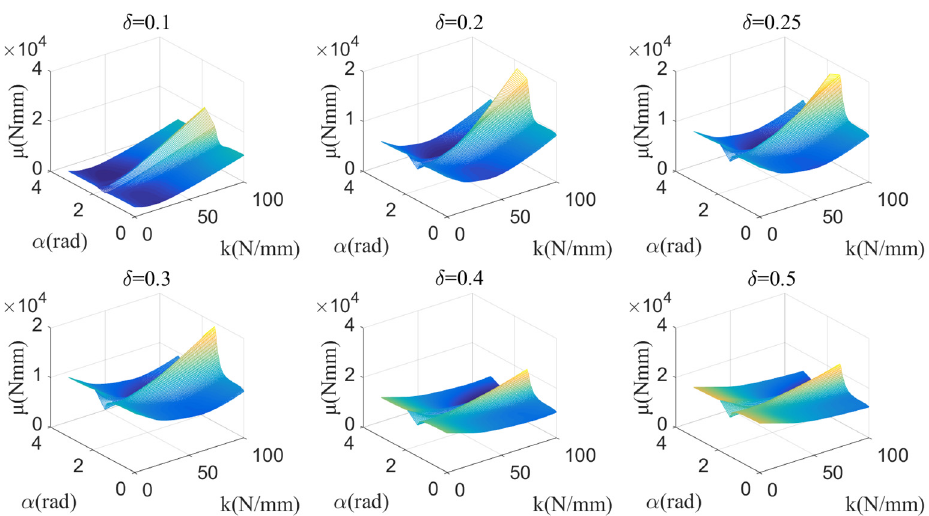
Figure 6. Dispersion value of the HESM under different parameters.